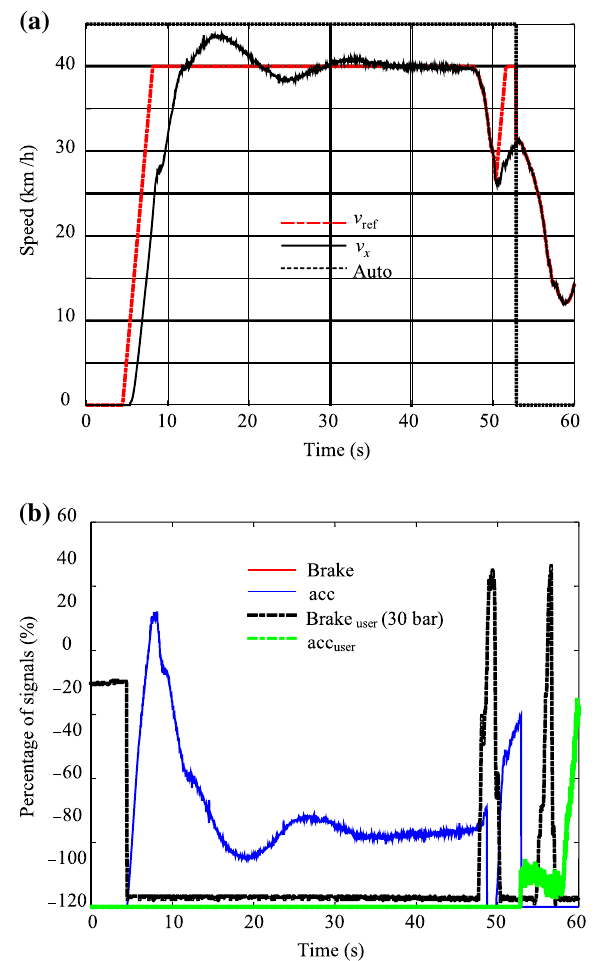
Fig. 11 Results of the longitudinal speed control test. a Longitudinal speed of the car. b Acceleration and brake signals under driver control (acc user and Brake user ) and automated control (acc and